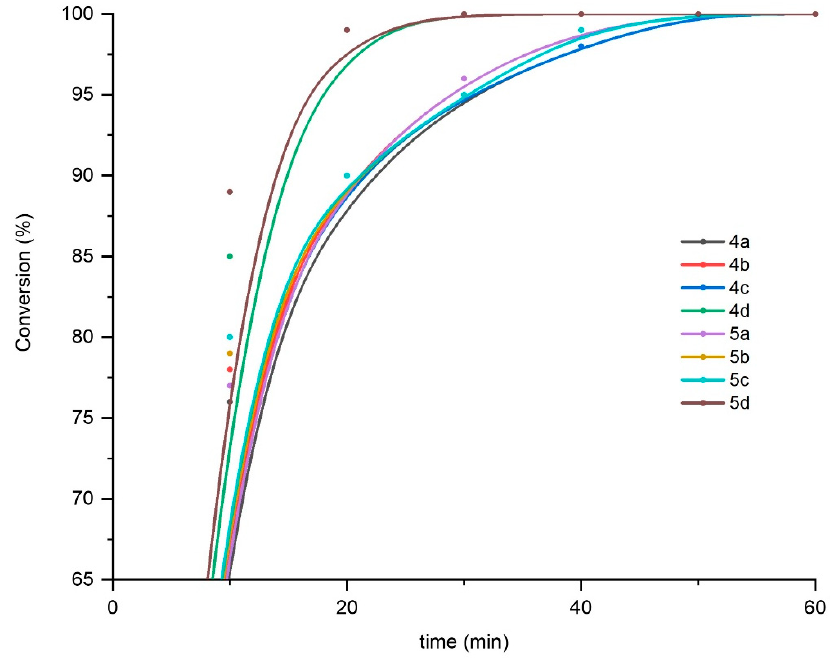
Figure 4. Time/conversion curves for RCM transformations of 7 (0.8 mmol, 200 mg) to 8 under the action of catalysts 4a – d and 5a – d . Conditions: catalyst loading is 0.1 mol% (0.0008 mmol), 25 °C, Ar, dry CH 2 Cl 2 (20 mL). A fragment of the kinetic curve is presented to better reflect the course of reactions with various catalysts.